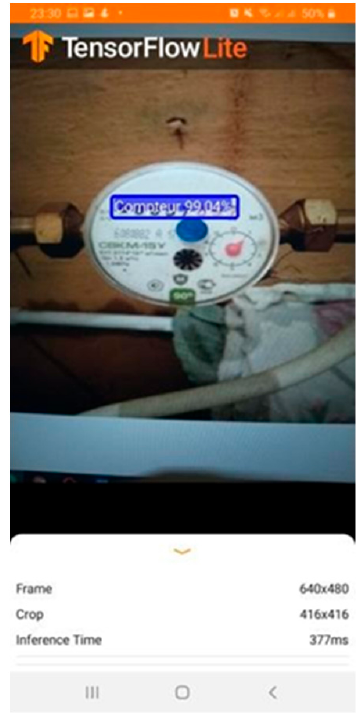
Figure 16. The real time detection interface.